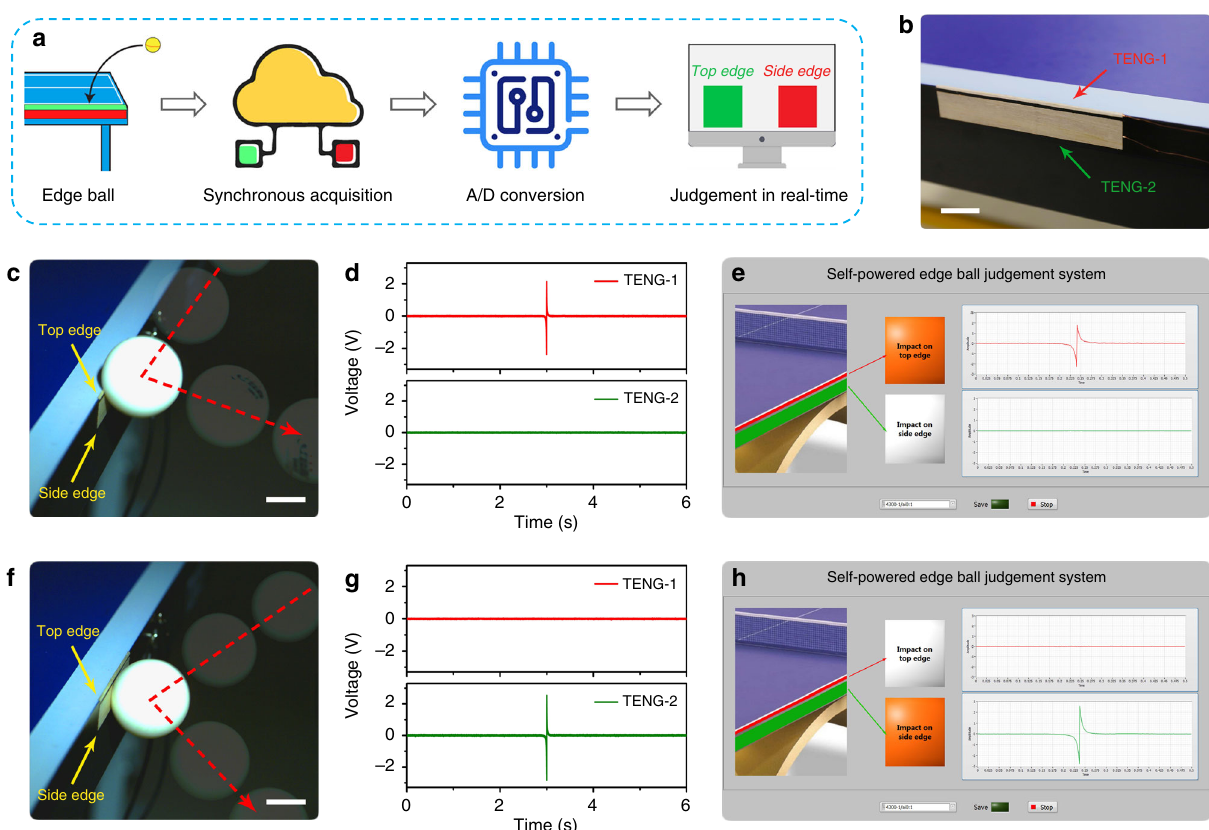
Fig. 5 Application of the W-TENG in a self-powered edge ball judgement system. a Scheme diagram of the W-TENG based self-powered edge ball judgement system. b Photograph of two W-TENGs attached on the edge of the ping-pong table. Scale bar, 2 cm. c – e Demonstration of the self-powered edge ball judgement system at the moment of top edge ball appeared: c Photograph, d output signals of two W-TENGs, and e screenshot of the real-time judgement result showing a ping-pong ball impacted on the top edge of the table. Scale bar, 2 cm. f – h Demonstration of the self-powered edge ball judgement system at the moment of side edge ball appeared: f Photograph, g output signals of two W-TENGs, and h screenshot of the real-time judgement result showing a ping-pong ball impacted on the side edge of the table. Scale bar, 2